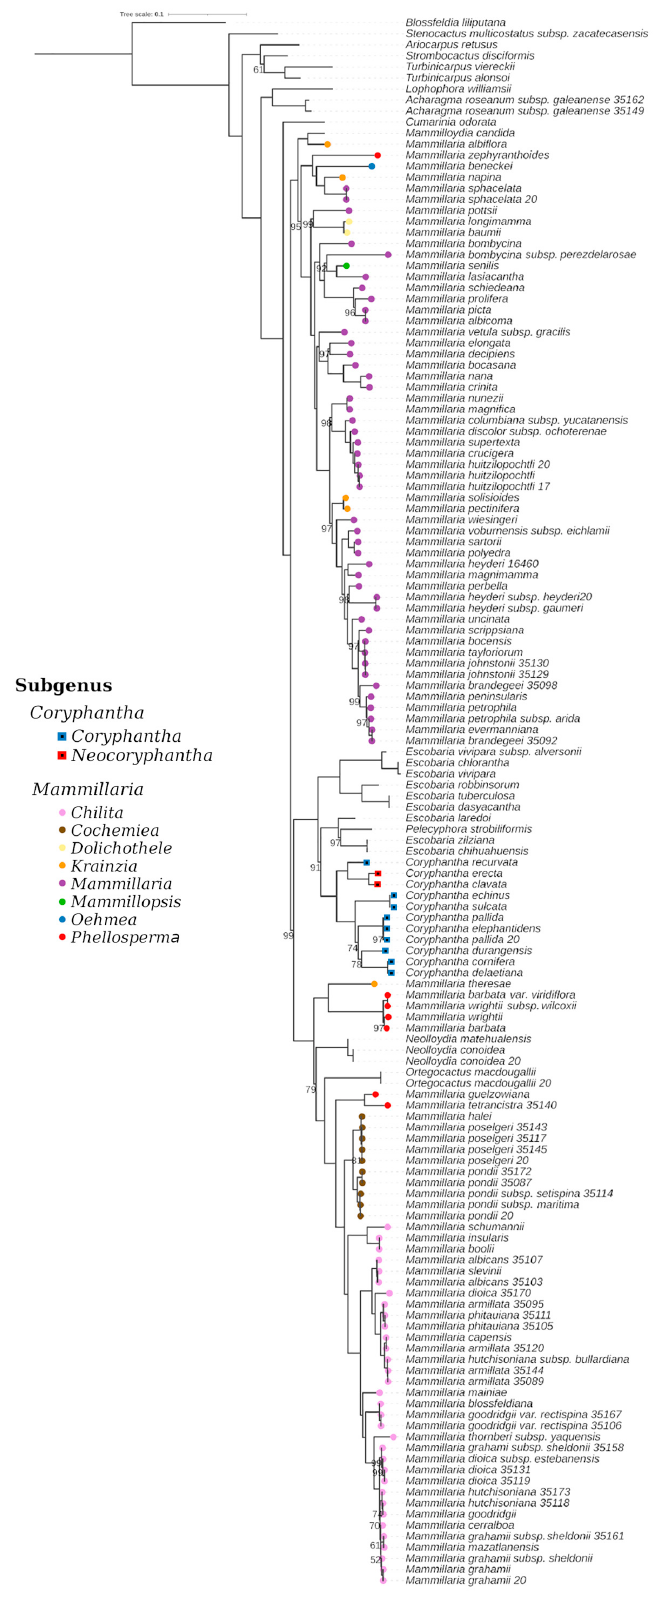
Figure 2. Phylogenetic tree estimated with IQ-TREE2 for the 103 taxa (142 specimens) using B. liliputana as the outgroup. Numbers below the nodes indicate UFBoot values < 100. Colored circles and squares indicate subgenera for Mammillaria and Coryphantha ,